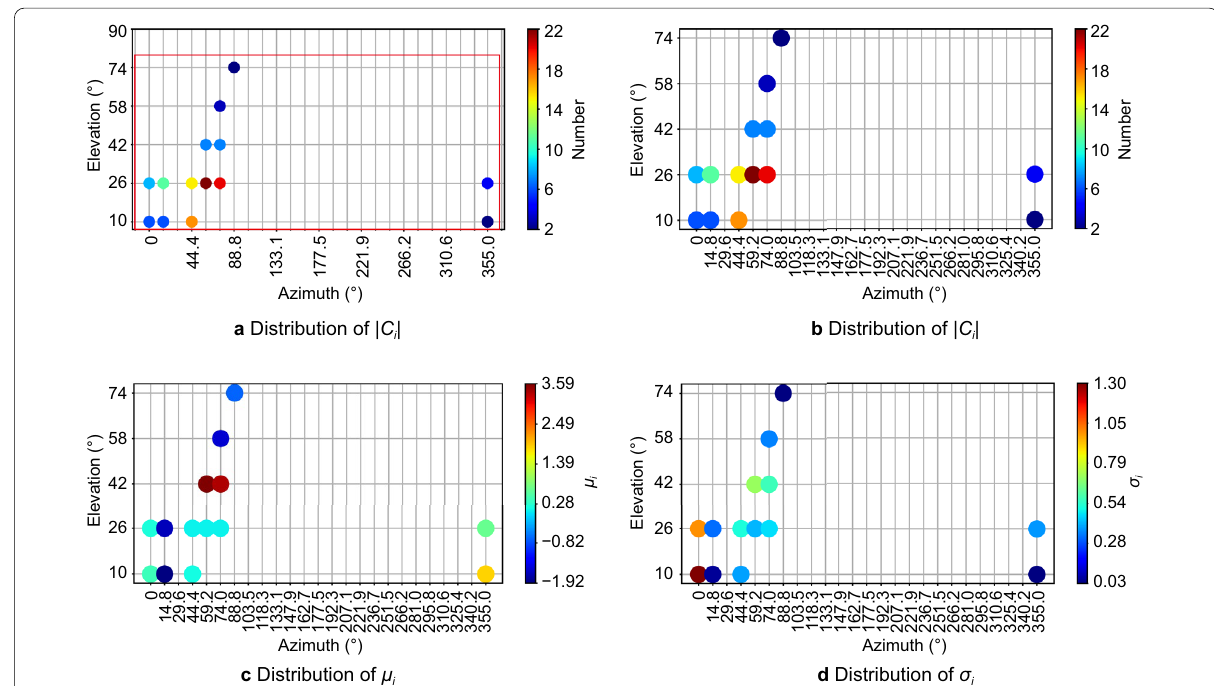
Fig. 5 Distribution of | C i | (the top two sub‑plots), μ i (the left‑bottom sub‑plot), σ i (the right‑bottom sub‑plot) in Eq. (7) against elevation angle and azimuth angle for latitude 64.6° and longitude 40.7° of solution A ( 12 × 8 × 6 × 25 ) on DOY 001, 2020